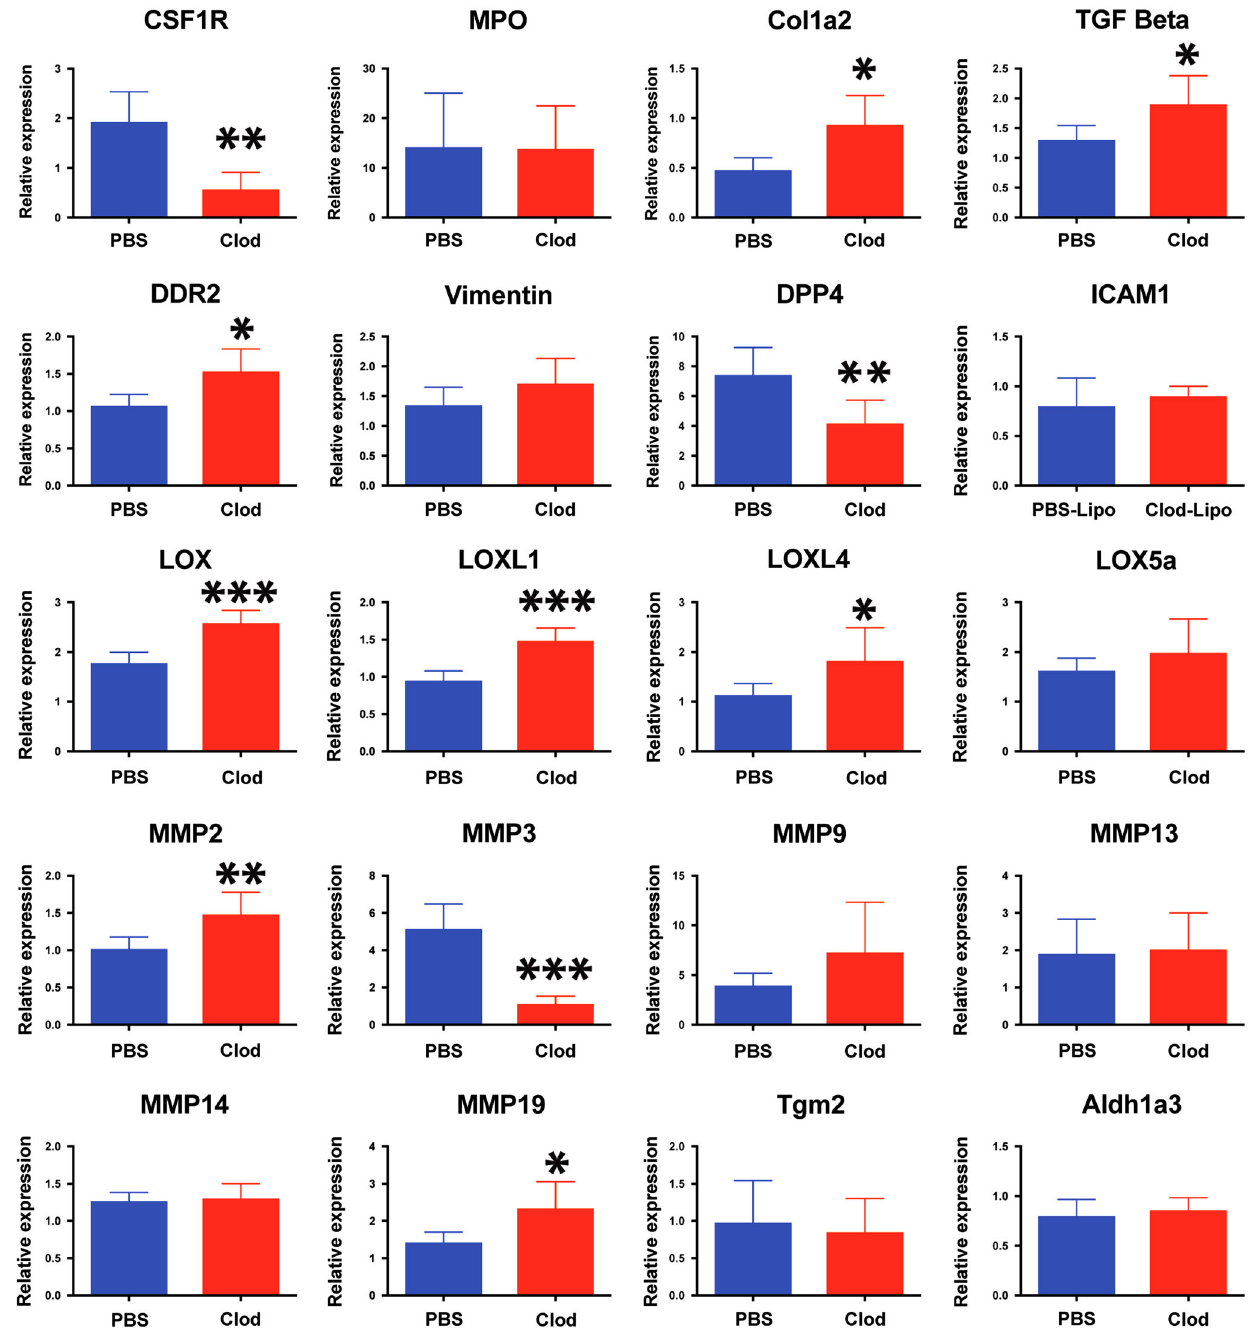
Fig. 6 Gene expression analysis of macrophage depleted hearts post cryo-injury identi fi es molecular targets regulating ECM regulation during regeneration. RT-PCR analysis of 7 dpi cryo-injured hearts isolated from Clo-Lipo and PBS-Lipo control animals. Heart ventricle samples were screened for a list of candidate genes (partially isolated from previous RNAseq studies) that regulate ECM turnover and maturation during regeneration. N = 5 animals, at least 3 independent experiments performed. (see Methods section for